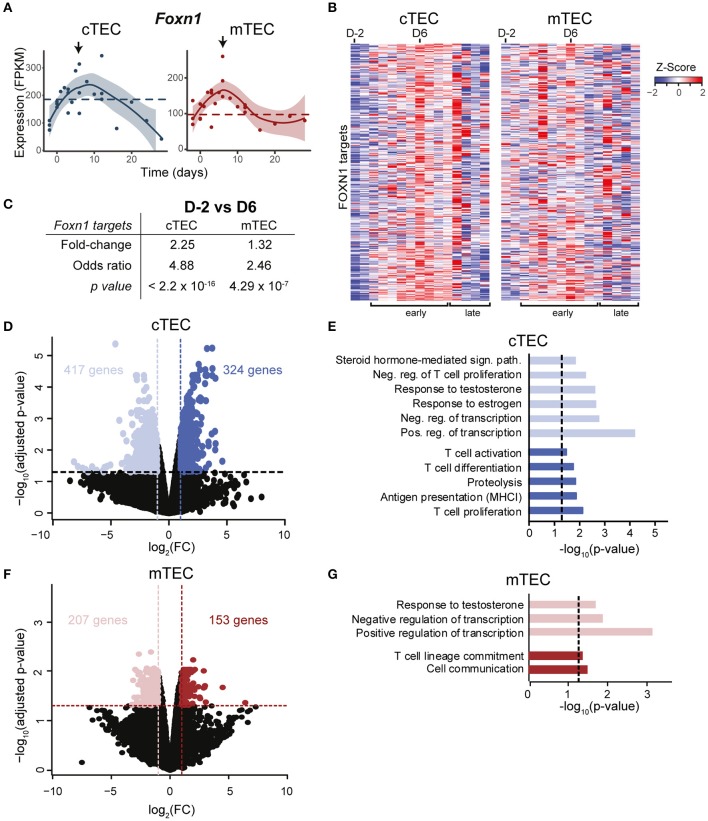
Transcriptomic changes in TECs during postpartum regeneration. (A)
Foxn1 expression in cTECs and mTECs. Each replicate is represented with a dot. Black lines represent non-linear regression and the 95% confidence intervals are displayed as shaded areas (blue for cTECs, red for mTECs). Average expression in NPC is depicted with a dashed line. (B) Expression of FOXN1 target genes, as defined by (33). Gene expression is shown as relative expression (Z-score), for D-2 to D28 (one column per time point). (C) Average fold-change in expression of FOXN1 targets between D-2 and D6. Odds Ratio and significance were assessed with Fisher exact test, for fold-change > 2. Gene expression for each time point represents either average expression for triplicates, or raw expression value for individual replicates. (D) Differential gene expression in cTECs between D-2 (pale blue) and D6 (dark blue). (E) Enriched GO-terms in cTECs between D-2 and D6. (F) Differential gene expression in mTECs between D-2 (pale red) and D6 (dark red). (G) Enriched GO-terms in mTECs between D-2 and D6.